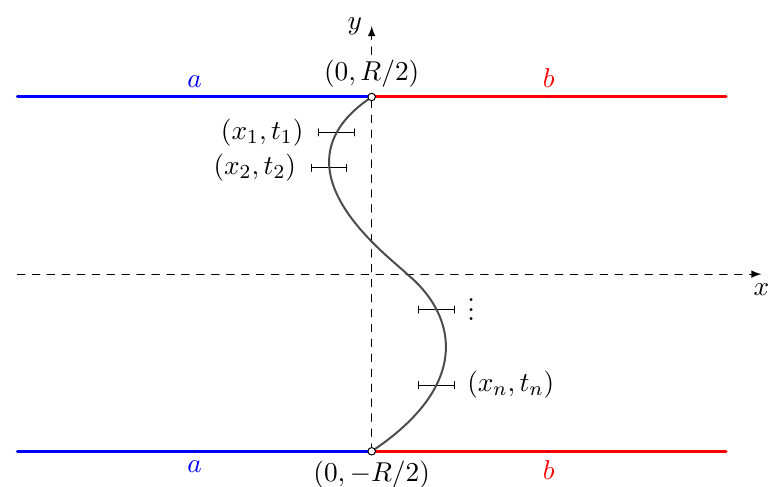
Figure 3. The multi-interval construction of the passage probability P n with the time t j identified according to